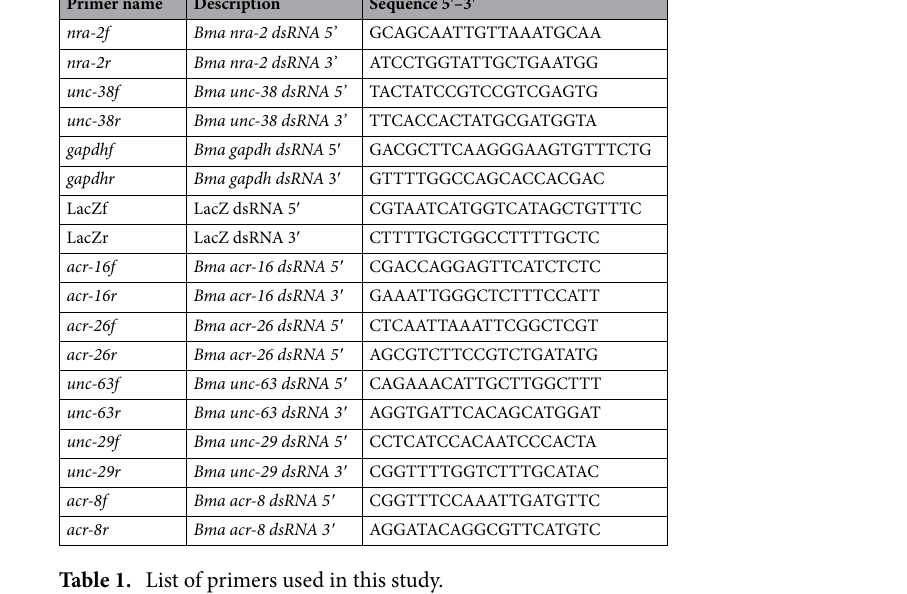
Table 1. List of primers used in this